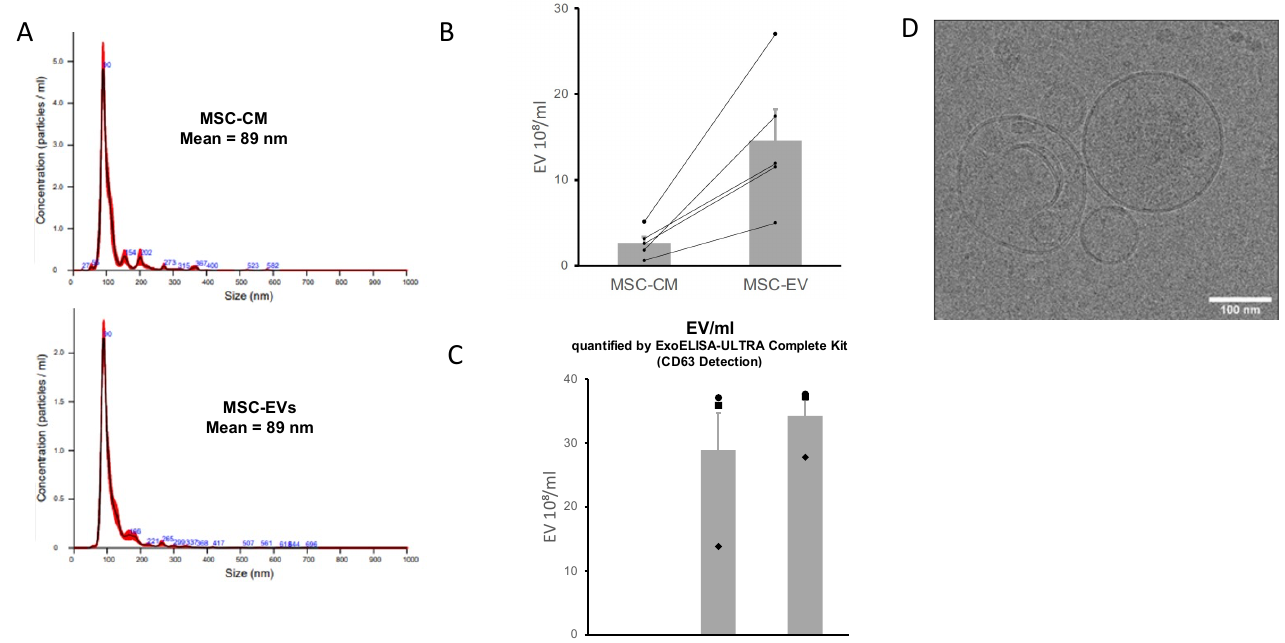
Figure 4. MSC-CM and MSC-EVs characterization. ( A ): Graph showing the calculated mean ± SD of particles size distribution of MSC-EVs and MSC-CM samples by Nanoparticles Tracking Analysis (NTA). ( B ): Quantification of particles present in MSC-EVs and MSC-CM samples by NTA, graph showing the calculated mean ± SD, n = 5, p = 0.0159. ( C ): Quantification of particles present in MSC- EVs and MSC-CM samples by ELISA specific to CD63 detection (marker of extracellular vesicles), n = 3. ( D ): Visualization of particles in EVs sample by cryo-electron microscopy.